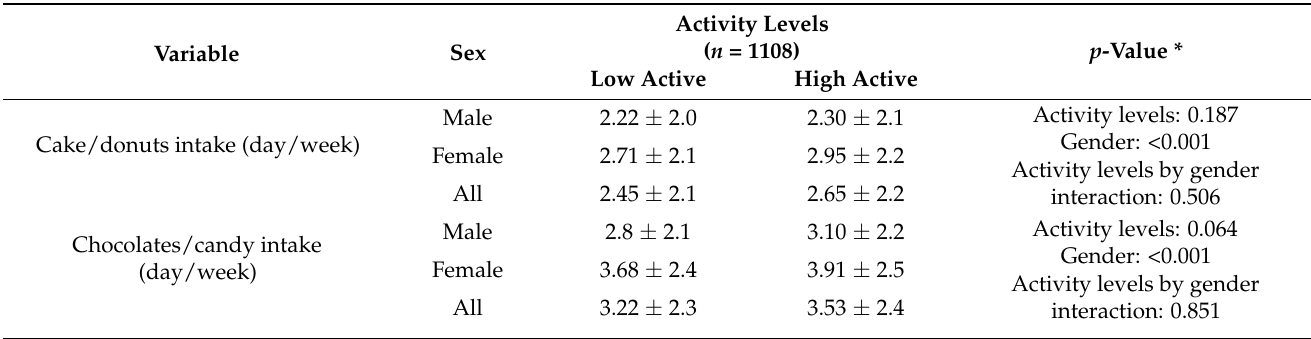
among Saudi adolescents, while adjusted for age, sex, and sociodemographic factors.